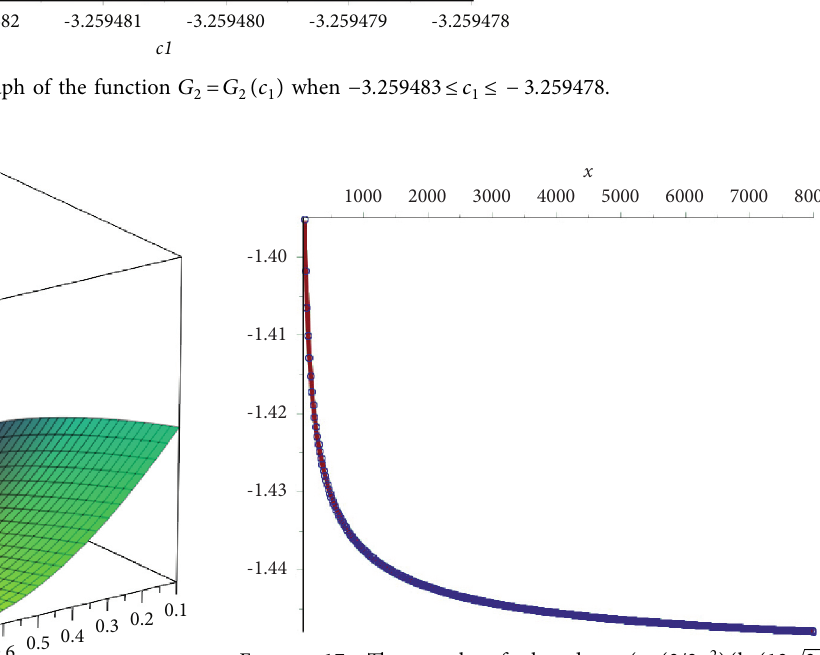
Figure 17: The graph of the data ( n, ( 3/2 π 2 )( ln ( 12 h ( n ) / π )) 2 − n ) and the fitting curve.